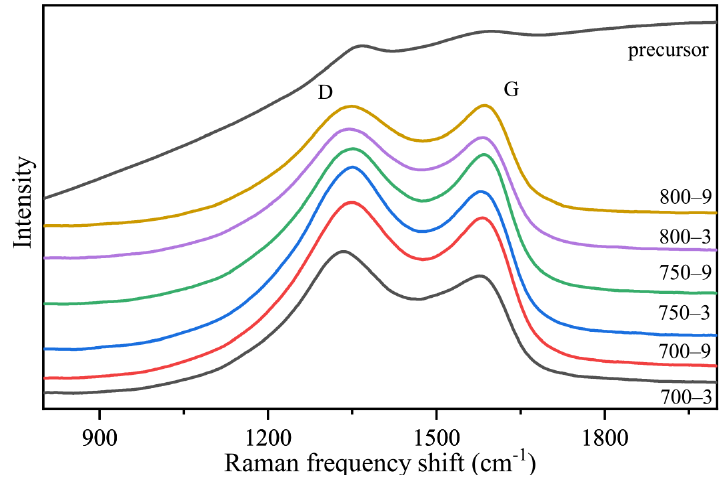
Figure 7. Raman spectra of the samples. Table 2. Raman spectra of the samples.